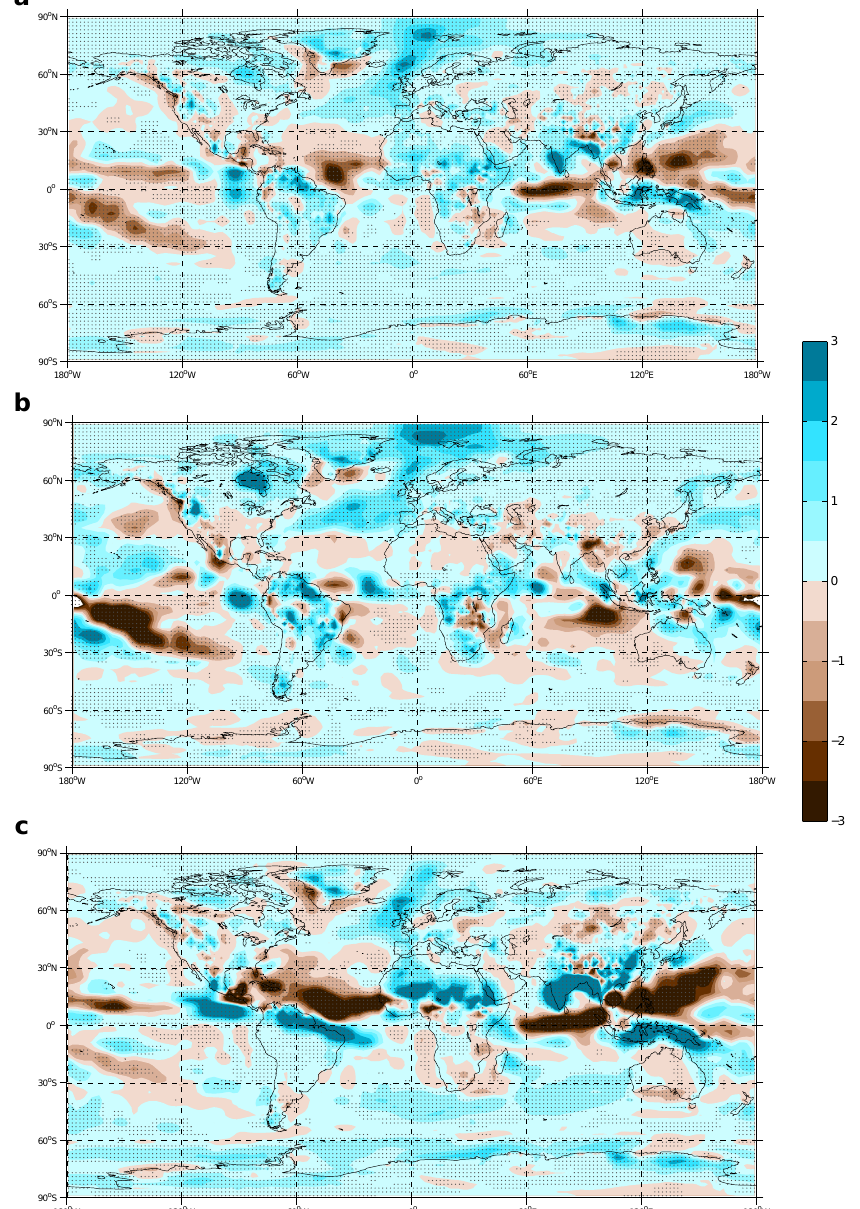
Fig. 9. Pliocene minus pre-industrial differences in model precipitation rates (mmd − 1 ). (a) Annual, (b) December-January-February, (c) June-July-August. Significant differences (stippled) are inferred by a Student t-test. of deglaciated Greenland and West and East Antarctica ice